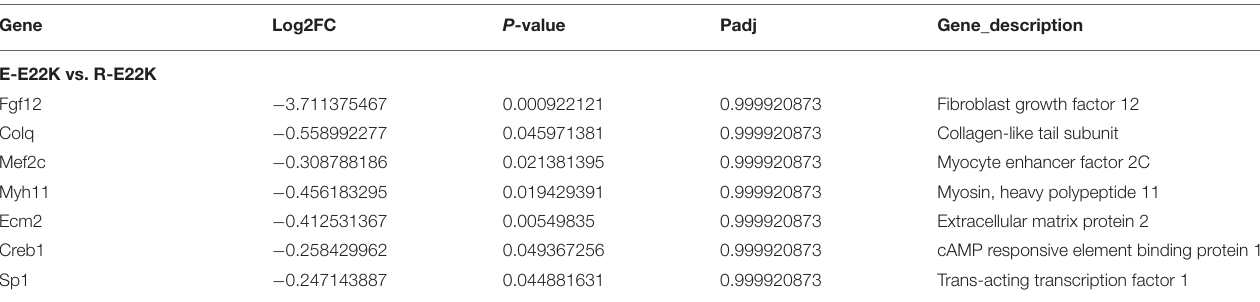
TABLE 3 | A list of significant DEGs in E22K mice before and after exercise. Gene Log2FC P -value Padj Gene_description E-E22K vs.